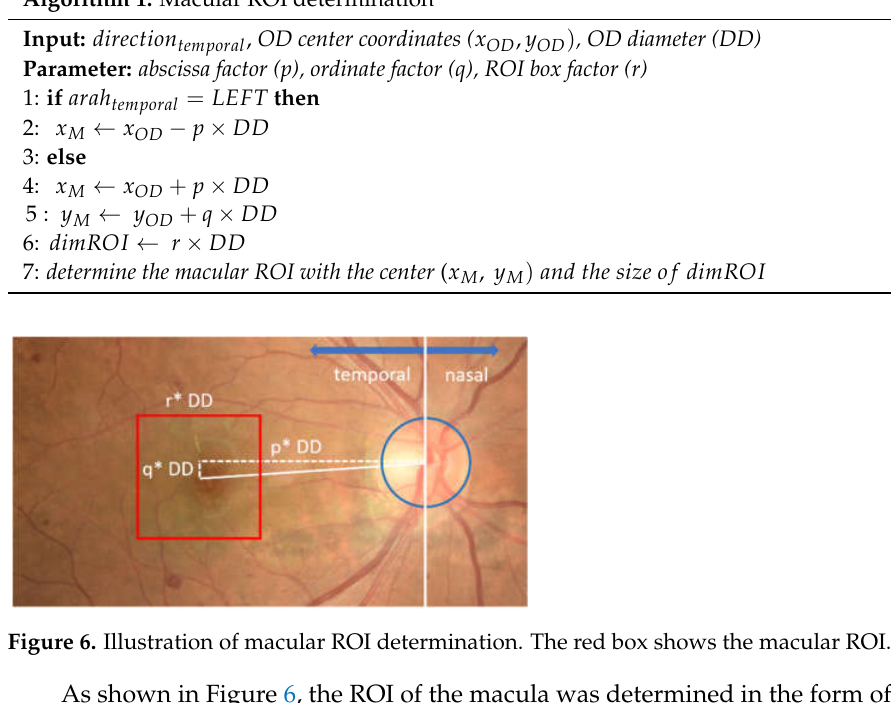
Figure 5. The extraction process of blood vessels on the optic disc; ( a ) optic disc on the green layer; ( b ) the extraction result of blood vessels on the optic disc; ( c ) the result of elimination of horizontal